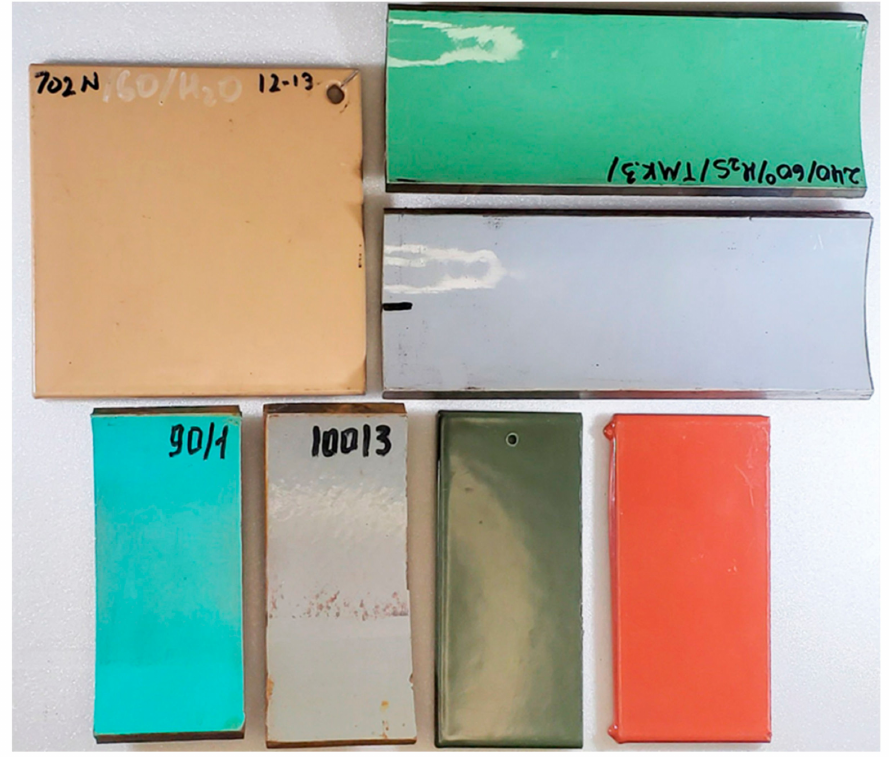
Figure 1. Testing samples.